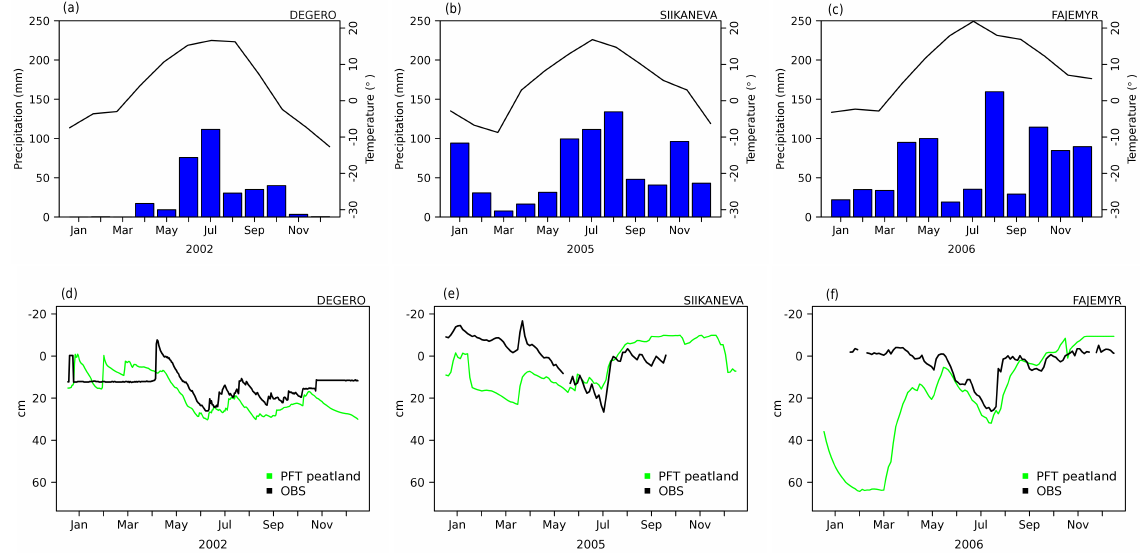
Figure 5. Monthly mean temperature (black line) and monthly precipitation (blue bars) at the top and seasonal cycle of modelled (green) and observed (black) water table depth (WTD) at the bottom for the peatland sites of Degero (a) , Siikaneva (b) and Fajemyr (c)